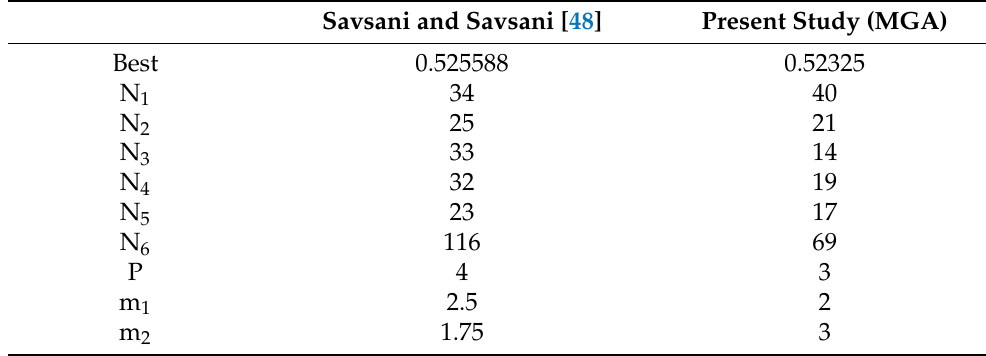
Table A13. Comparison of the best solutions for the planetary gear train design problem.